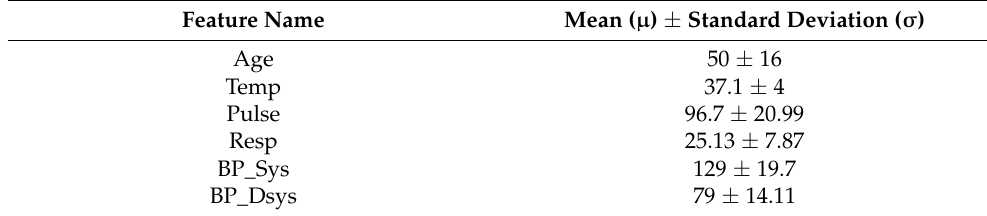
Table 2. Statistical description of the numeric